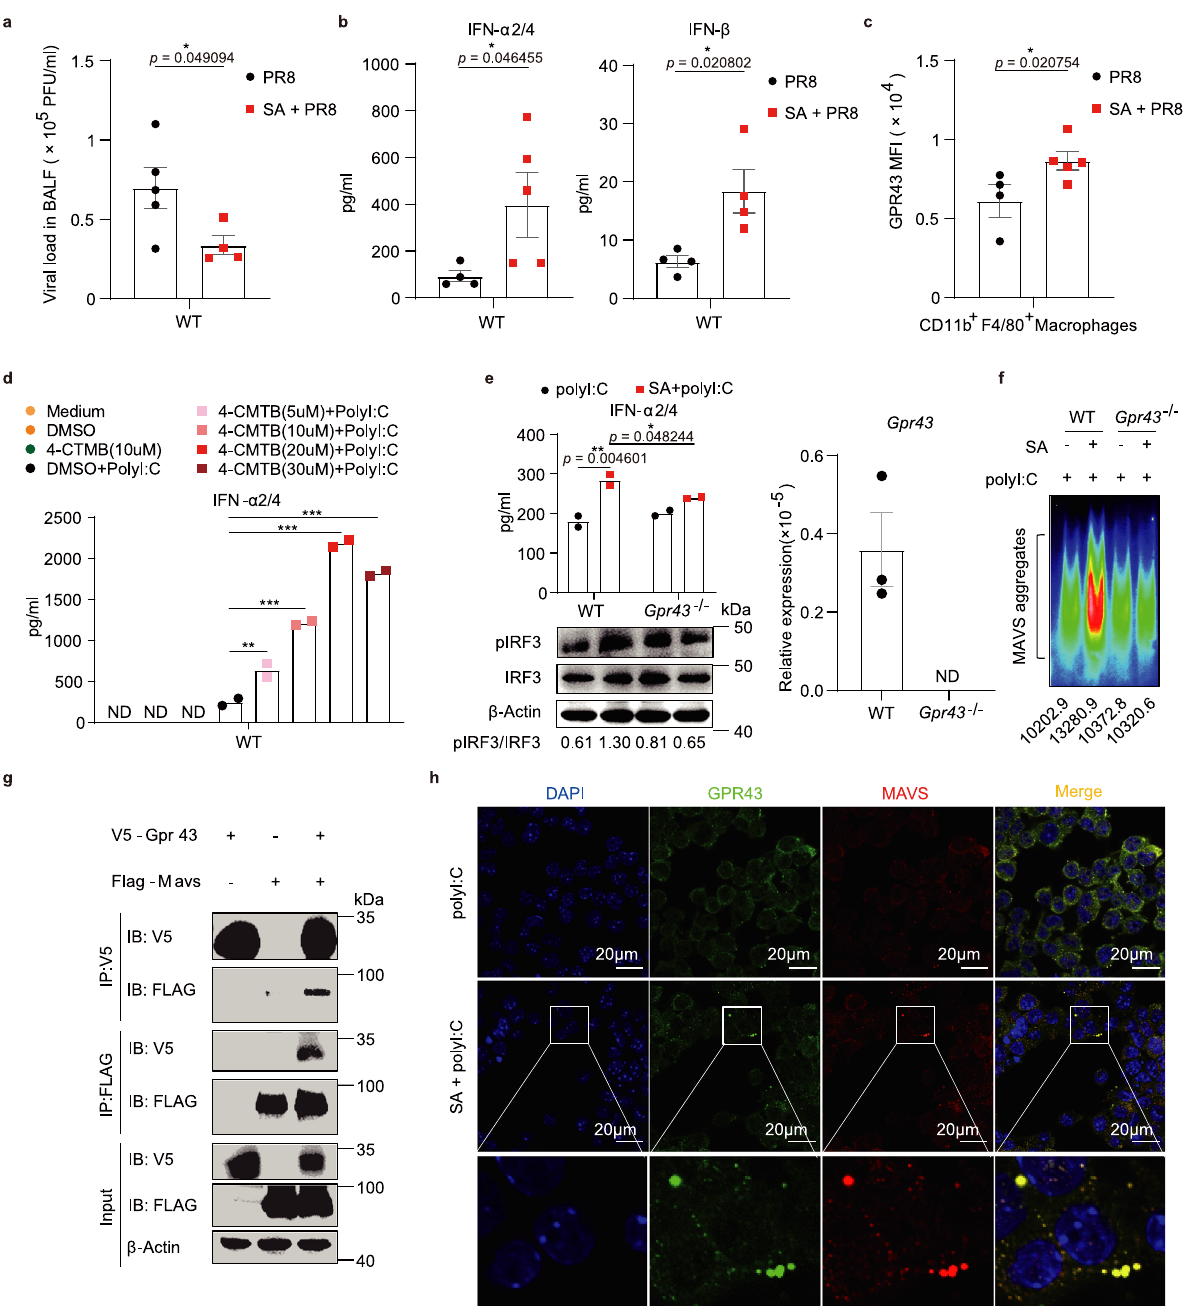
Fig.6|AcetatepromotesMAVSaggregationthroughGPR43.a – c WTmicewere expression was determined by qPCR. f WT or Gpr43 − / − BMDMs were transfected,